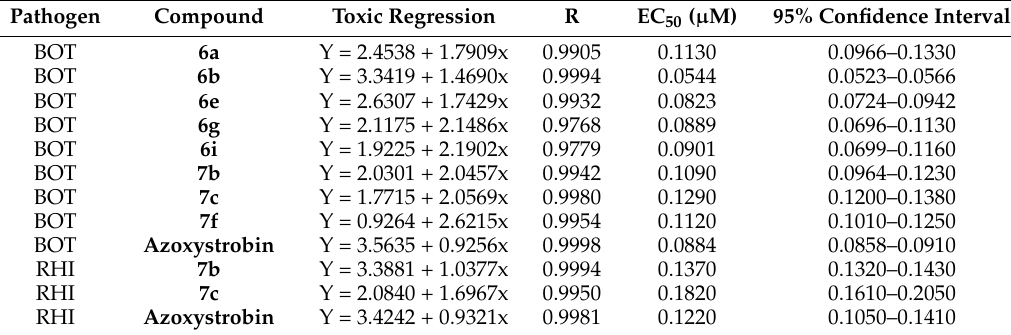
Table 2. EC 50 determination of some active